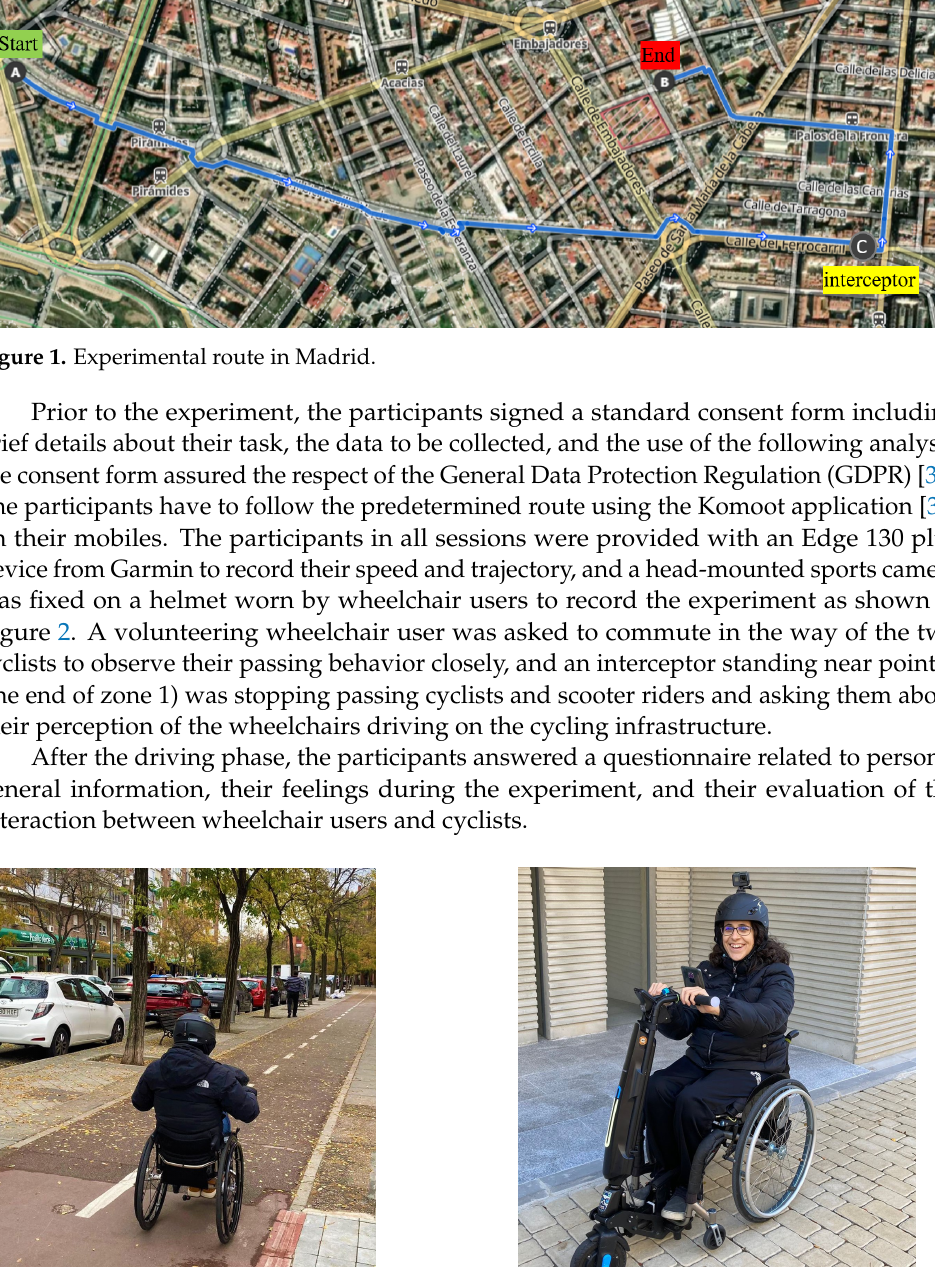
Figure 2. Two of the participants wearing a helmet with a camera and holding a mobile to follow the experimental